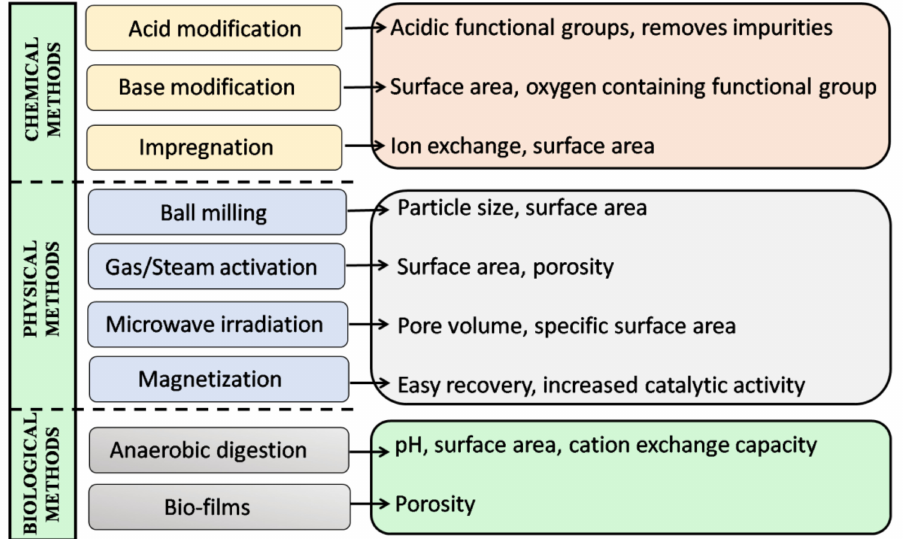
Figure 5. Schematic representation of different methods used for preparation of engineered biochar and their effect on the properties of